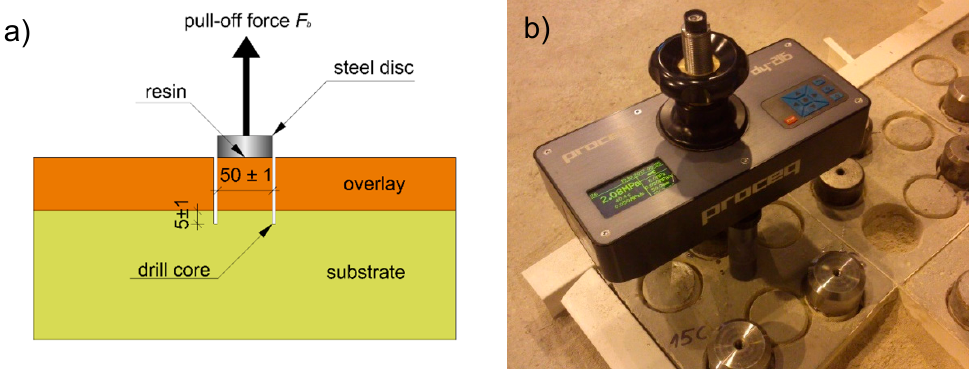
Figure 4. The scheme of the pull-off method (a) and a view of the testing device (b).